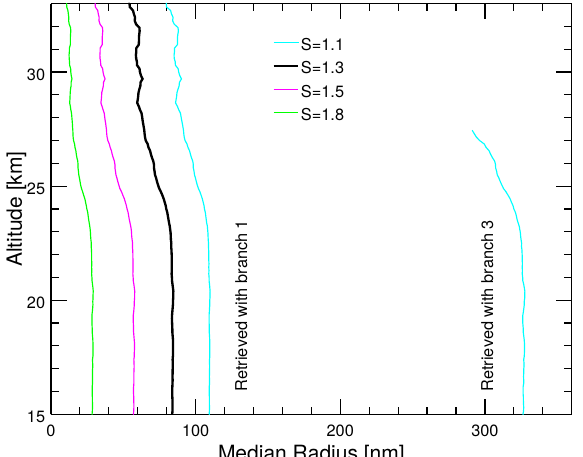
Figure 4. Retrieved median radius profiles based on branch 1 (curves on the left) and branch 3 (cyan curve on the right). The branch 1 retrievals are shown for different distribution widths S to illustrate its influence on the radius retrieval. For S < 1.1, a radius assignment using branch 3 exists for the altitude range up to about 28 km as shown in the rightmost profile. Shown are median radius profiles that are computed from monthly mean backscatter ratio profiles for March